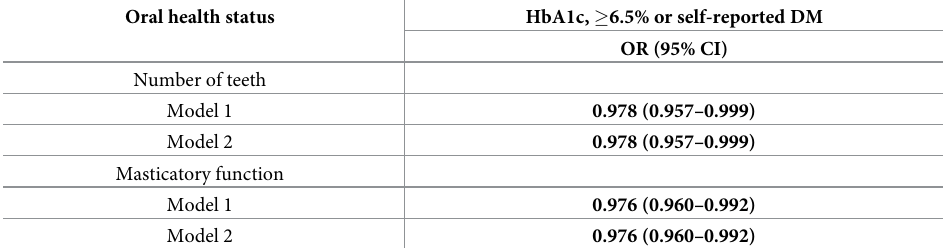
Table 3. Association between oral health status and diabetes mellitus status among community-dwelling Japanese adults (N = 635).